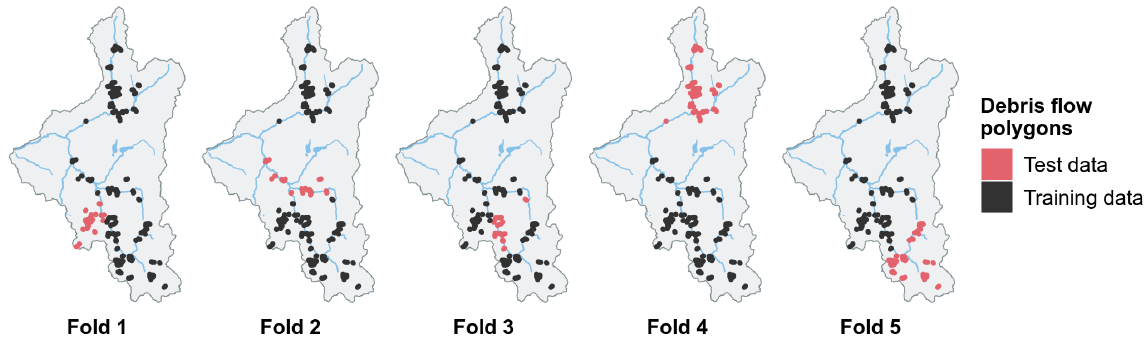
Figure 3. An example realization of random partitions based on k -means clustering of debris-flow polygons for a single repetition of 5-fold spatial cross-validation. The selection of these debris-flow polygons was based on a random sample.